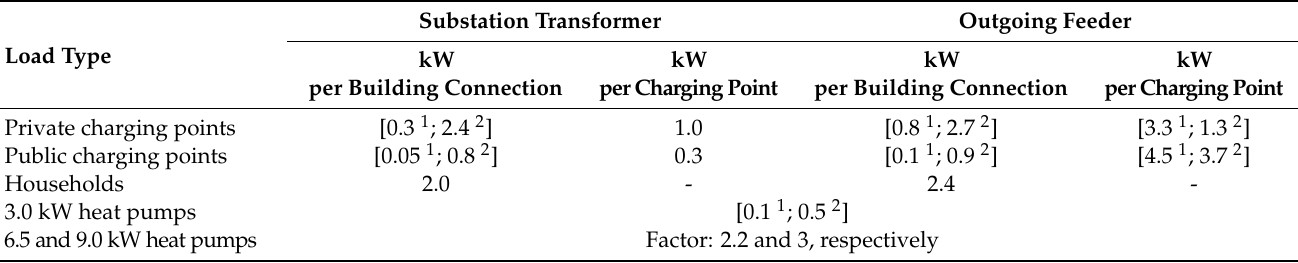
Table 5. Summary of the power value assumptions for the different load types and dimensioning views based on